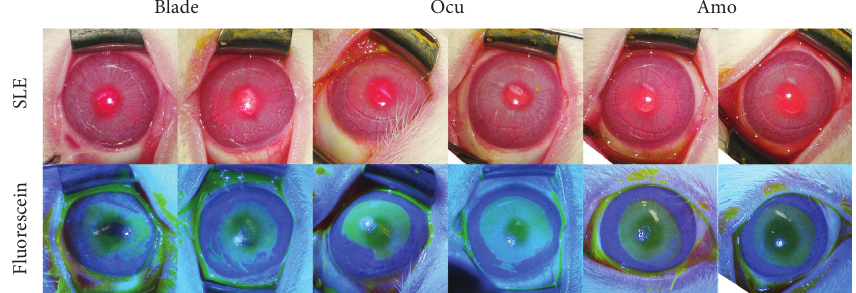
Figure 1: Light microscopic images taken immediately after epithelial removal before and after fluorescence staining in the three groups. Table 1: Ratio of the epithelial defect area at each time point after epithelial removal to the epithelial defect area immediately after epithelial removal.